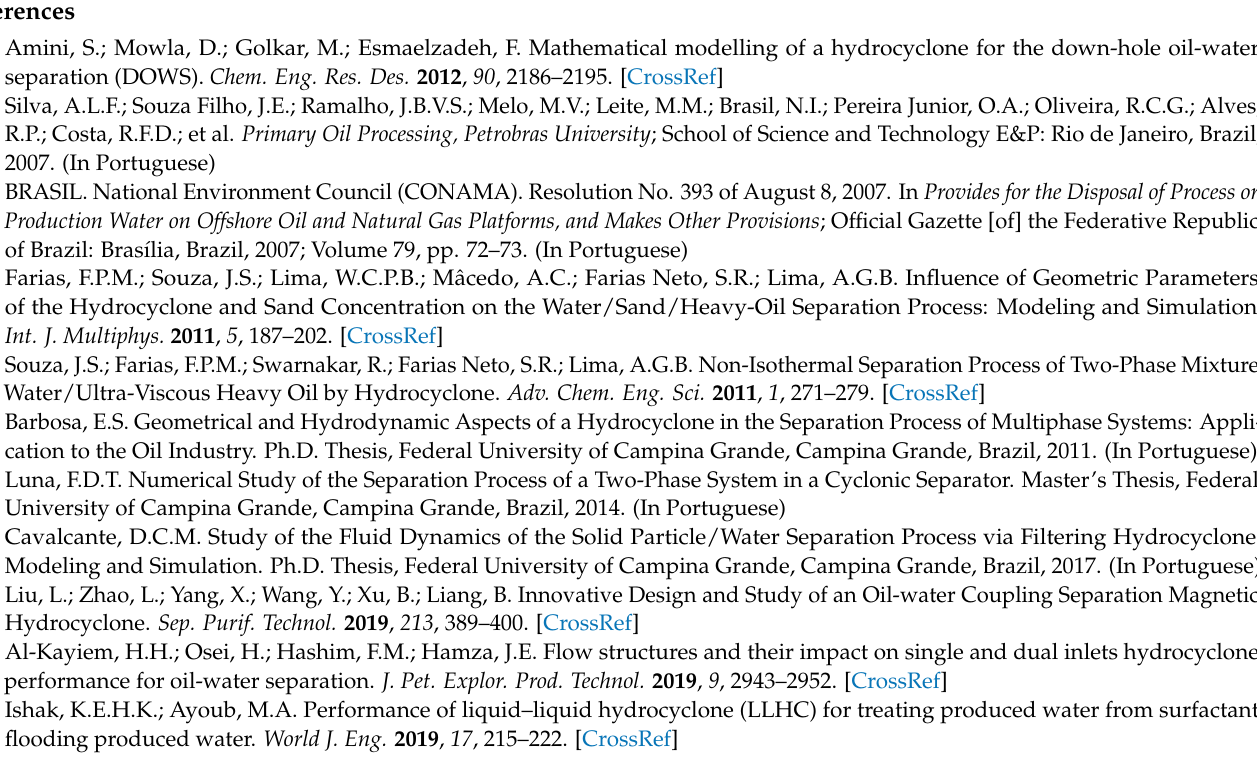
(e) The solute rejection coefficient by the membrane does not significantly affect the hydrodynamic behavior of the fluids inside the filtering cyclonic separator in the range 0.96 ≤ R ≤ 1.00. However, for higher membrane rejection coefficients (R = 1.00), there is a decrease in the mass flow rate of the permeate (1.822 kg/m 2 s), with minimal oil concentration in this mixture (0.0 kg/m 3 ). (f) When the selective capacity of the membrane is increased, the transmembrane pressure remains practically constant ( ≈ 787.2 kPa), with a slight increase ( ≈ 806.0 kPa) when considering the concentration polarization layer thickness ( δ p = 7.82 × 10 − 2 mm). (g) The efficiency of the hydrocyclone remained approximately constant in the range of 0.96 ≤ R ≤ 0.99 ( ≈ 94.3%), rising from this point until reaching a value of 96.33% for R = 1.00. This parameter was higher when the concentration polarization layer thickness was varied from δ p = 0 mm to δ p = 7.82 × 10 − 2 mm, except for R = 1.00, where an inverse behavior was verified ( ≈